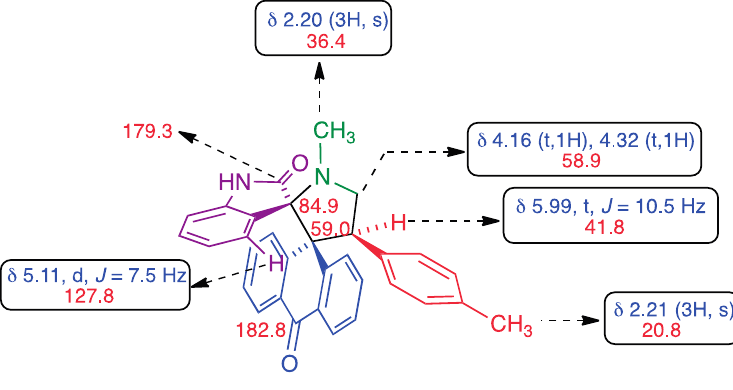
Figure 3. Key NMR data of model compound 6h